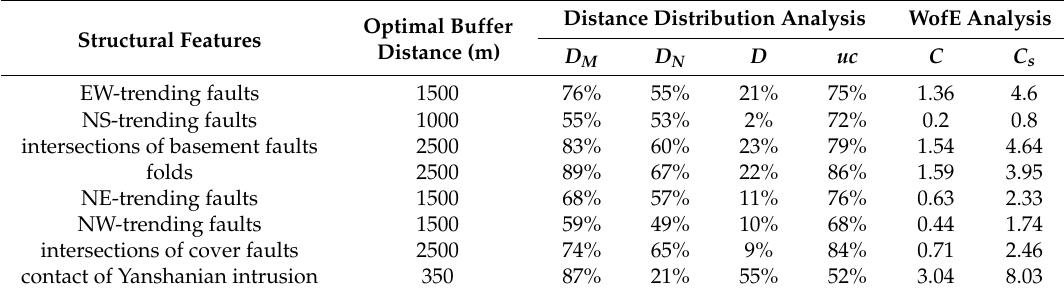
Figure 13. Graph showing variations of higher frequencies than expected, contrasts and confidences of contrast of detailed structural features in the TOD. Table 2. Results of distance distribution and WofE